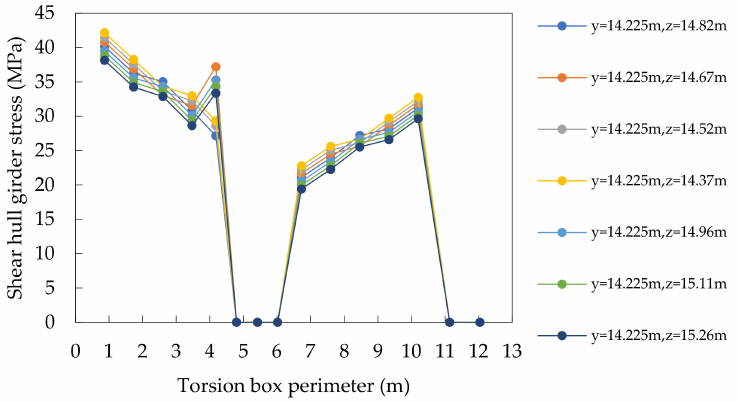
Figure 10. Evolution of shear hull girder stresses along the perimeter of the torsion box.